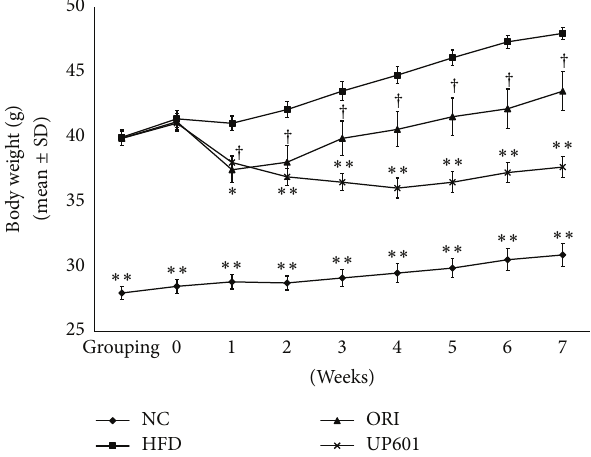
Figure 3: Body weight changes observed after 7 weeks of daily